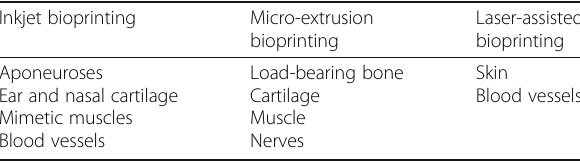
Table 1 Bioprinting method and possible printable